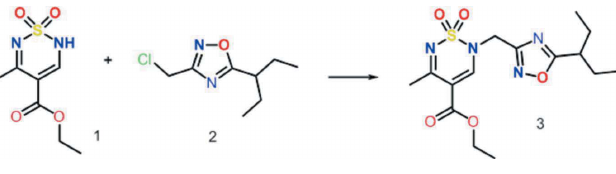
Figure 2 Synthesis of the title compound 3 .